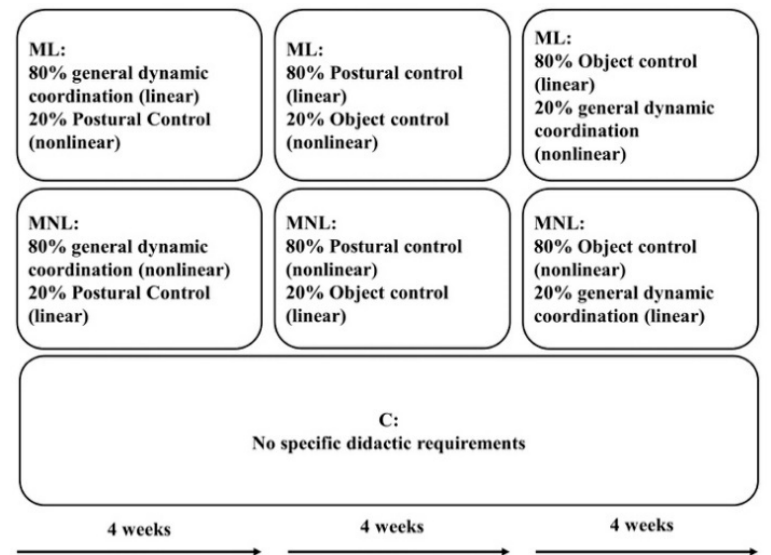
Figure 2. Periodization of PE contents. ML = multi-teaching approach emphasizing linear teaching; MNL = multi-teaching approach emphasizing nonlinear pedagogy; C = control (conventional teaching by generalists).